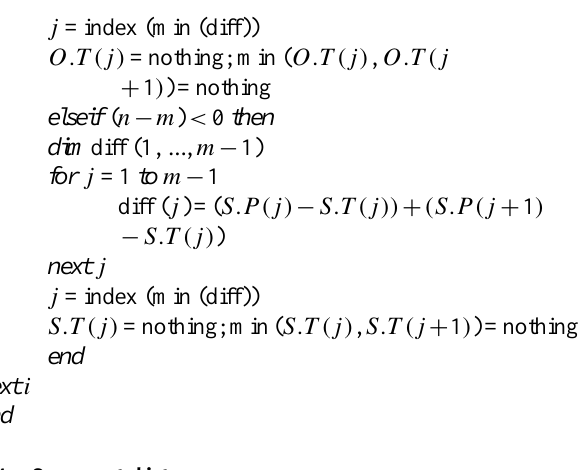
Algorithm to calculate the time and amplitude distance between matching segments in an observed and simulated event. The simulated segment is approximated by a polygon line. The polygon is sampled with n equally spaced points ( n being the number of points in the observed segment). These are used to calculate the distance from the n observed points in the